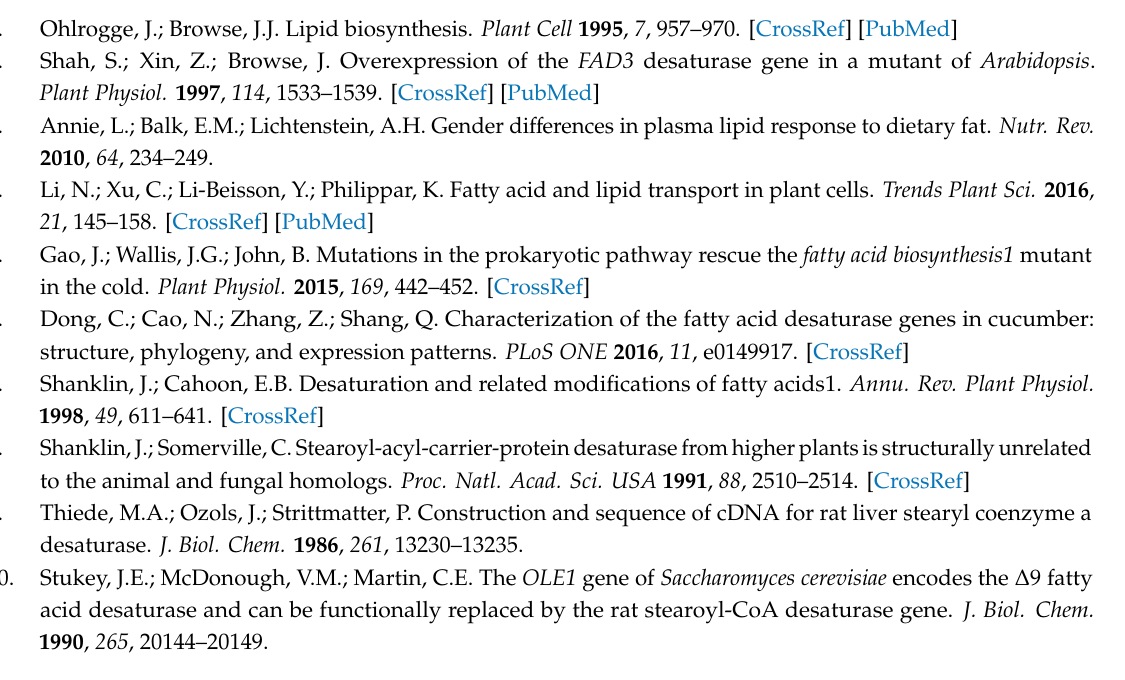
Figure S1: Chromosome location of fatty acid desaturase gene families; Figure S2: Correlations of expression levels with FAD genes under cold stress; Figure S3: Correlations of expression levels with FAD genes under heat stress; Figure S4: Expression level of transcription factors under cold stress and correlations of expression levels between FAD2.1–2.2 , SLD1 / 3 genes and transcription factors under cold stress; Figure S5: Expression level of transcription factors under heat stress and correlations of expression levels between FAD2.1 , SLD1 / 3 genes and transcription factors under heat stress; Figure S6: The cis- regulatory elements associated with some TFs and cold stress responses were predicted in the promoter regions of maize FAD genes; Table S1: Primers used for qRT-PCR; Table S2: Characteristics of fatty acid desaturase from maize; Table S3: The gene ID of fatty acid desaturase genes used in this study; Table S4: The syntenic relationships among maize and rice fatty acid desaturase genes; Table S5: The Pearson correlation analysis between TFs and target fatty acid desaturase